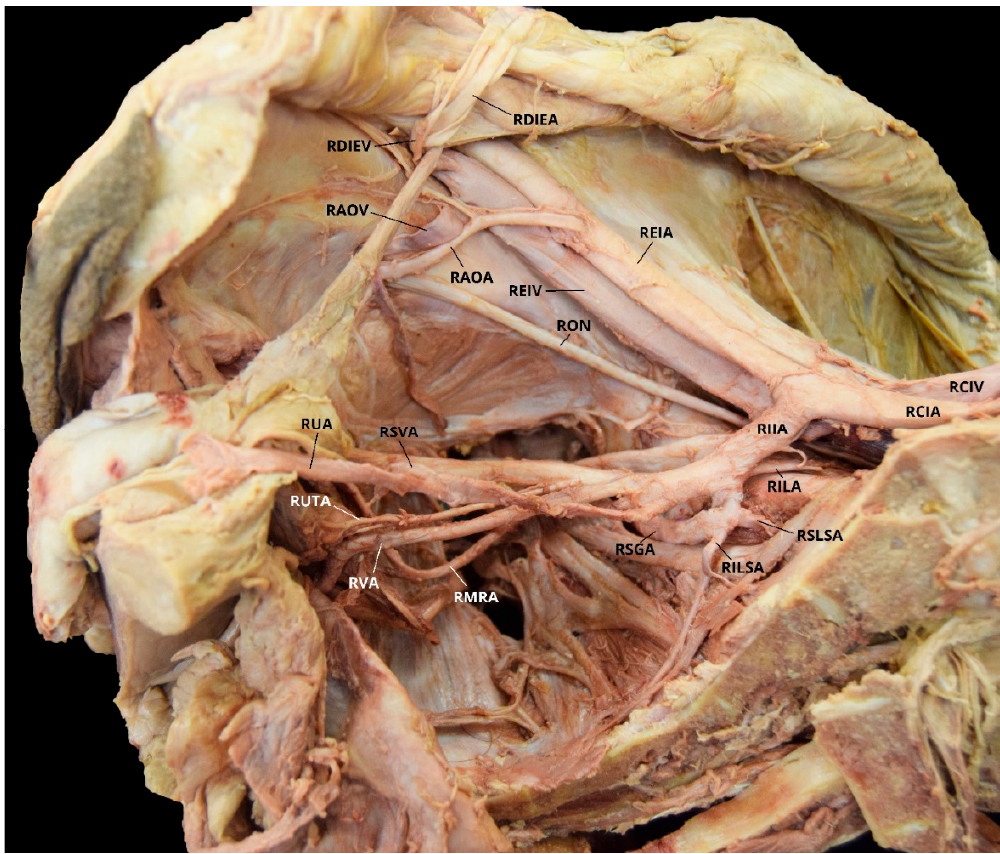
Figure 11. Facilitated display highlighting the right internal iliac artery branches with the right aberrant obturator artery for Case 6. RAOA = Right Aberrant Obturator Artery; RAOV = Right Aberrant Obturator Vein; RCIA = Right Common Iliac Artery; RCIV = Right Common Iliac Vein; RDIEA = Right Deep Inferior Epigastric Artery; RDIEV = Right Deep Inferior Epigastric Vein; REIA = Right External Iliac Artery; REIV = Right External Iliac Vein; RIIA = Right Internal Iliac Artery; RILA = Right Iliolumbar Artery; RILSA = Right Inferior Lateral Sacral Artery; RMRA = Right Middle Rectal Artery; RON = Right Obturator Nerve; RSGA = Right Superior Gluteal Artery; RSLSA = Right Superior Lateral Sacral Artery; RSVA = Right Superior Vesical Artery; RUA = Right Umbilical Artery; RUTA = Right Uterine Artery; RVA = Right Vaginal Artery. The Right Inferior Gluteal Artery (RIGA) and the Right Internal Pudendal Artery (RIPA) are not pictured.